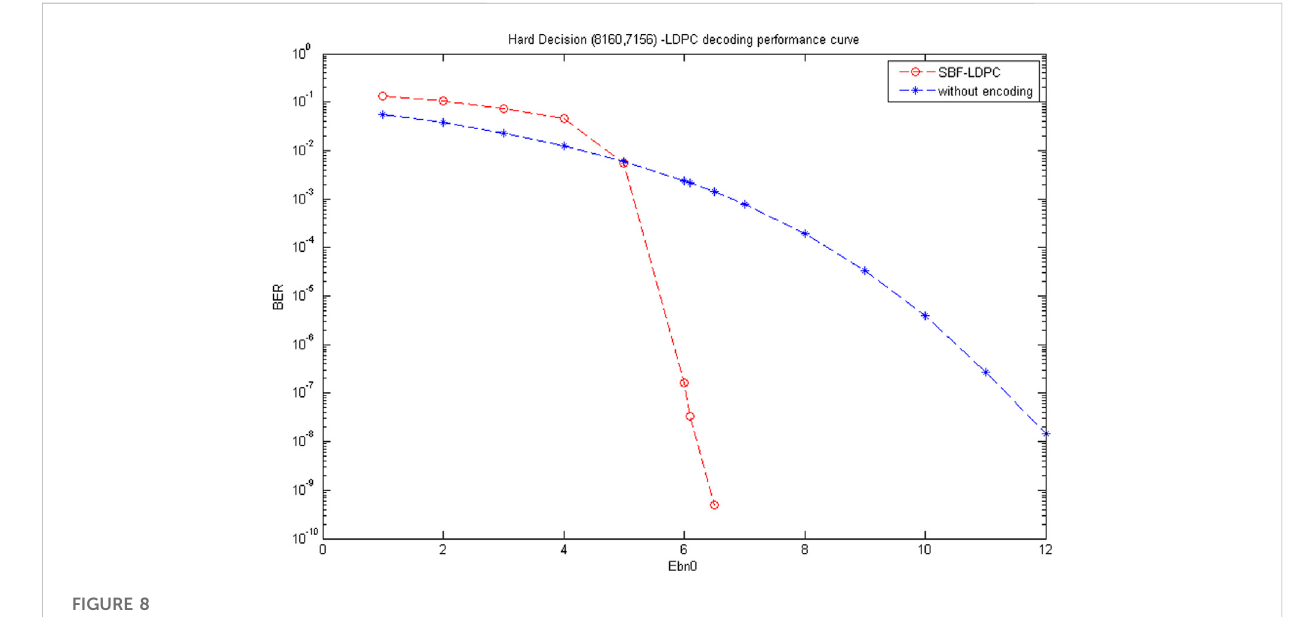
FIGURE 8 Simulation results of SBF decoder performance.